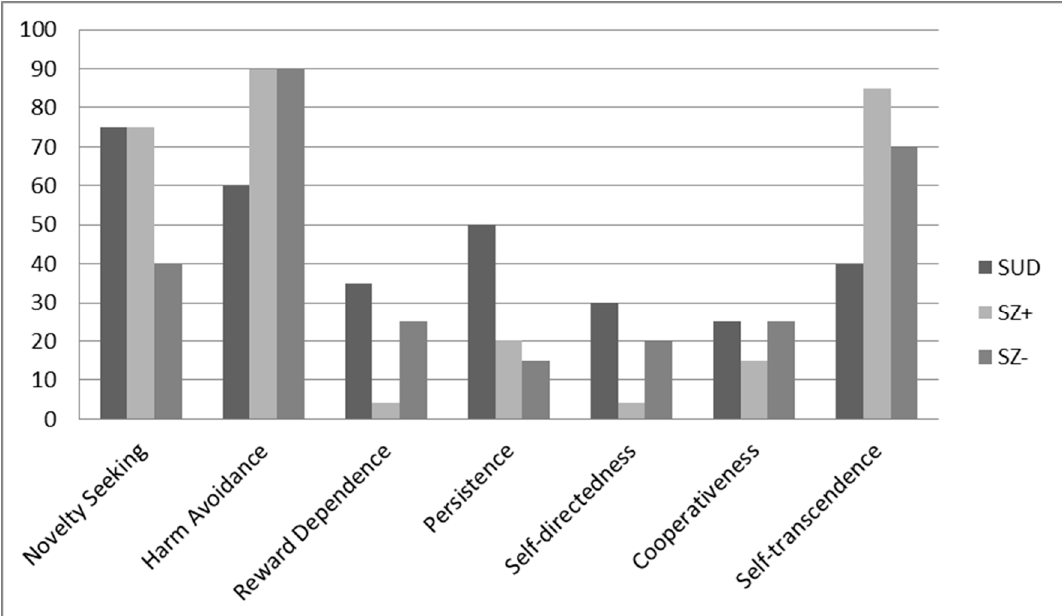
Figure 1. Percentile scores for the three groups for the Temperament and Character Inventory-Revised according to population norms. SUD: Substance use disorder; SZ+: Dual schizophrenia; SZ-: Schizophrenia.